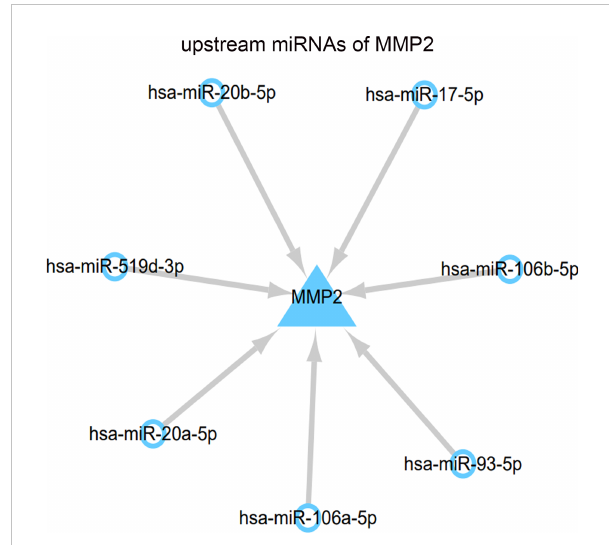
FIGURE 6 Regulatory network of MMP2 and upstream